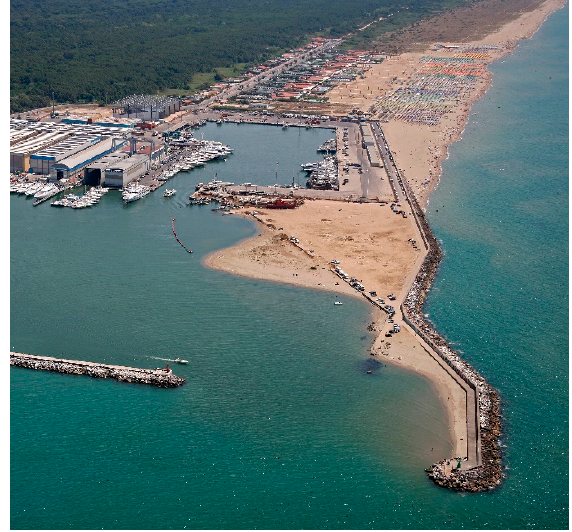
Figure 5. The updrift breakwater of Viareggio harbour and the beach close to it. Note that the sun umbrella are far from the cabanas, bars and restaurants.